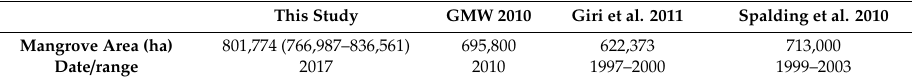
Table 9. Comparison of Mangrove Area estimated by Global